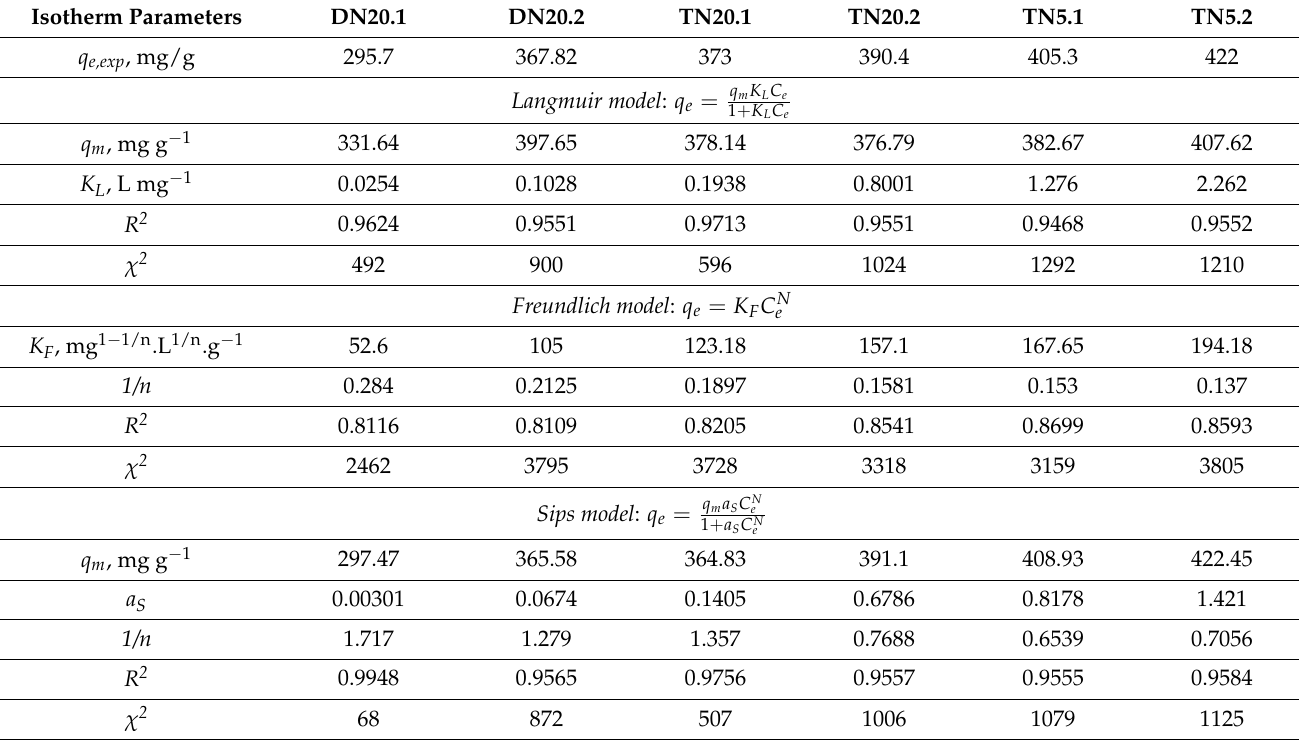
Table 6. Isotherm parameters for the sorption of H 2 PO 4 − anions onto DN and TN composite